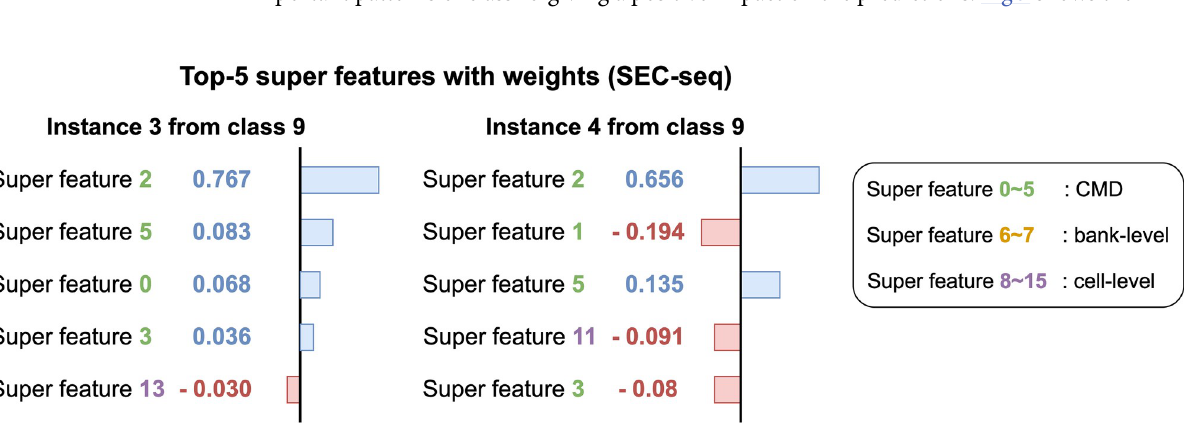
PLOS ONE | https://doi.org/10.1371/journal.pone.0282595 March 6,